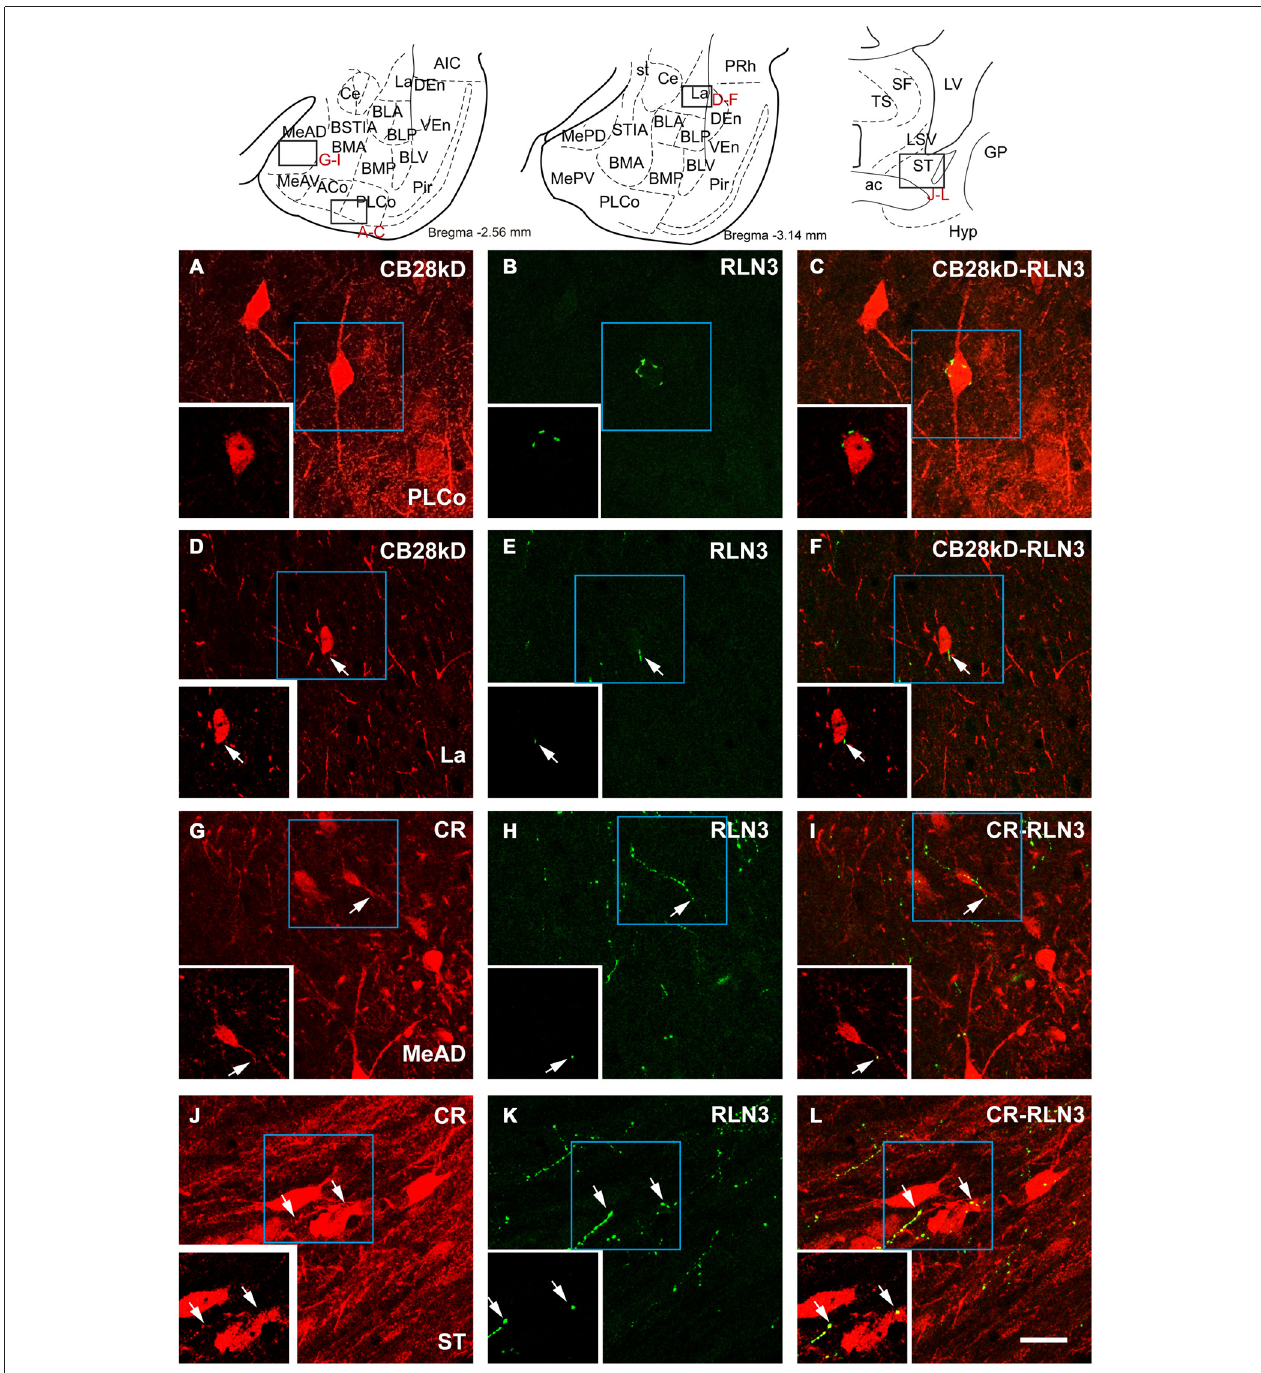
FIGURE 11 | Confocal images of close apposition between calcium binding positive neurons and processes and relaxin-3 positive fibers . Large images correspond to a maximal projection of stacks of 20 images of scans of 0.3 µ m. Insets illustrate a single 0.3 µ m section illustrating the contact. (A–C) Contact between a relaxin-3 fiber and a CB28kD somata in PLCo. (D–F) Contact of a relaxin-3 fiber with a CB28kD fiber in the La. (G–I) Contacts between RLN3 fibers and CR positive somata and processes in the MeAD. (J–L) Contacts between RLN3 fibers and CR somata and processes in the STM. Calibration bar 20 µ m.